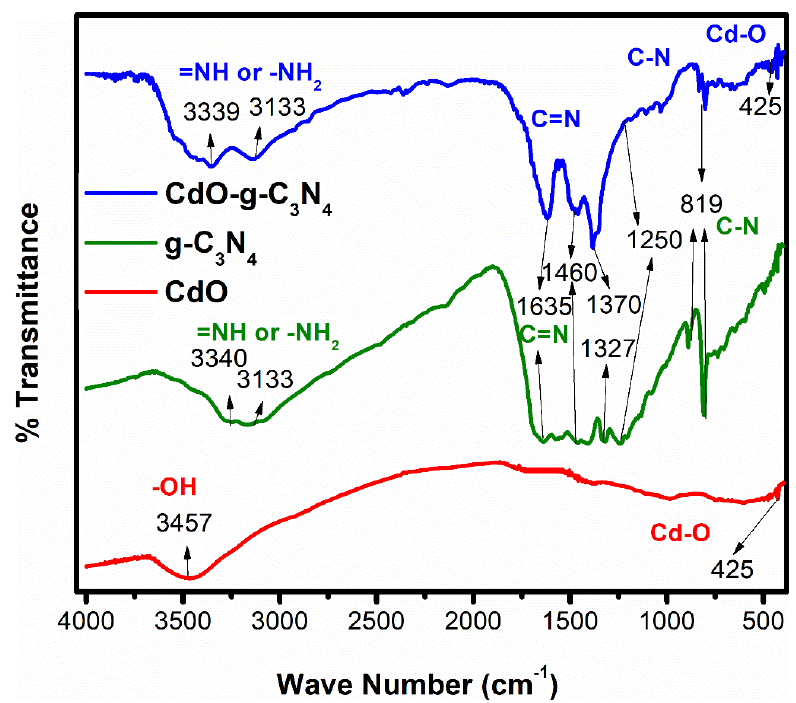
Figure 3. FTIR spectra of pure g-C 3 N 4 , CdO nanorods, and CdO-g-C 3 N 4 photocatalysts.